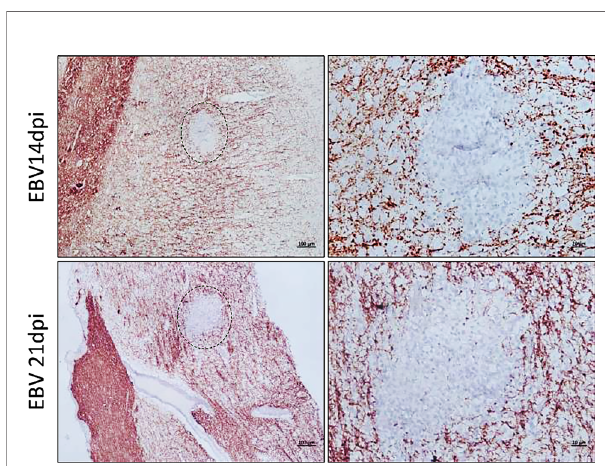
FIGURE 9 | In fl ammatory aggregates in the EBV infected brain are free of myelinated nerve fi bers. Brain sections were examined for demyelination in and around the aggregates by immunostaining for MBP. Demyelination was evident within aggregates developed at 14dpi and 21dpi. Scale bar at lower magni fi cation=100µm. Scale bar at higher magni fi